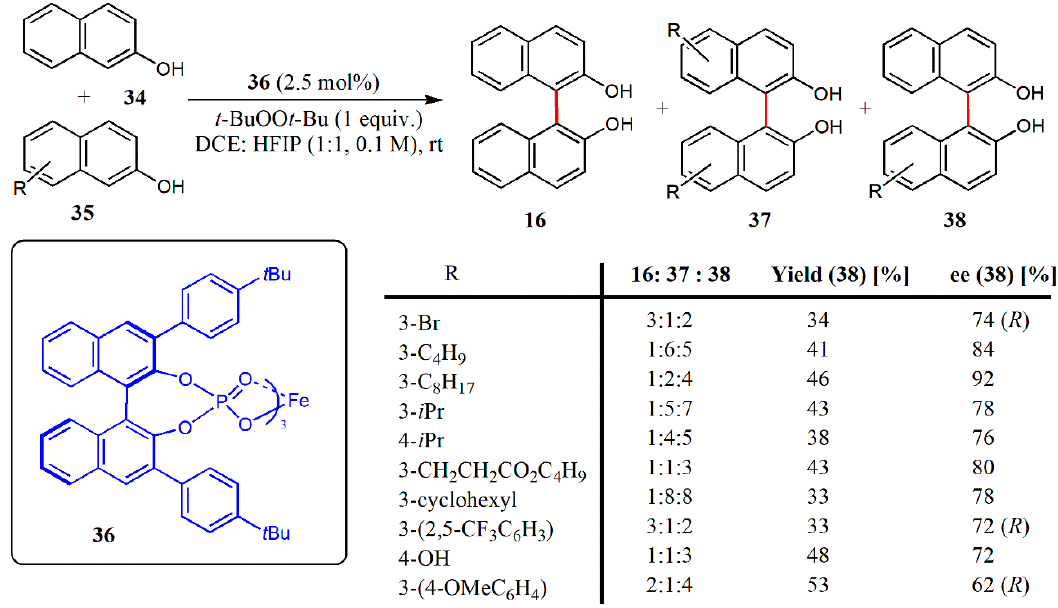
Figure 11. Enantioselective CDC of 2-naphthols catalyzed by chiral iron phosphate complexes.